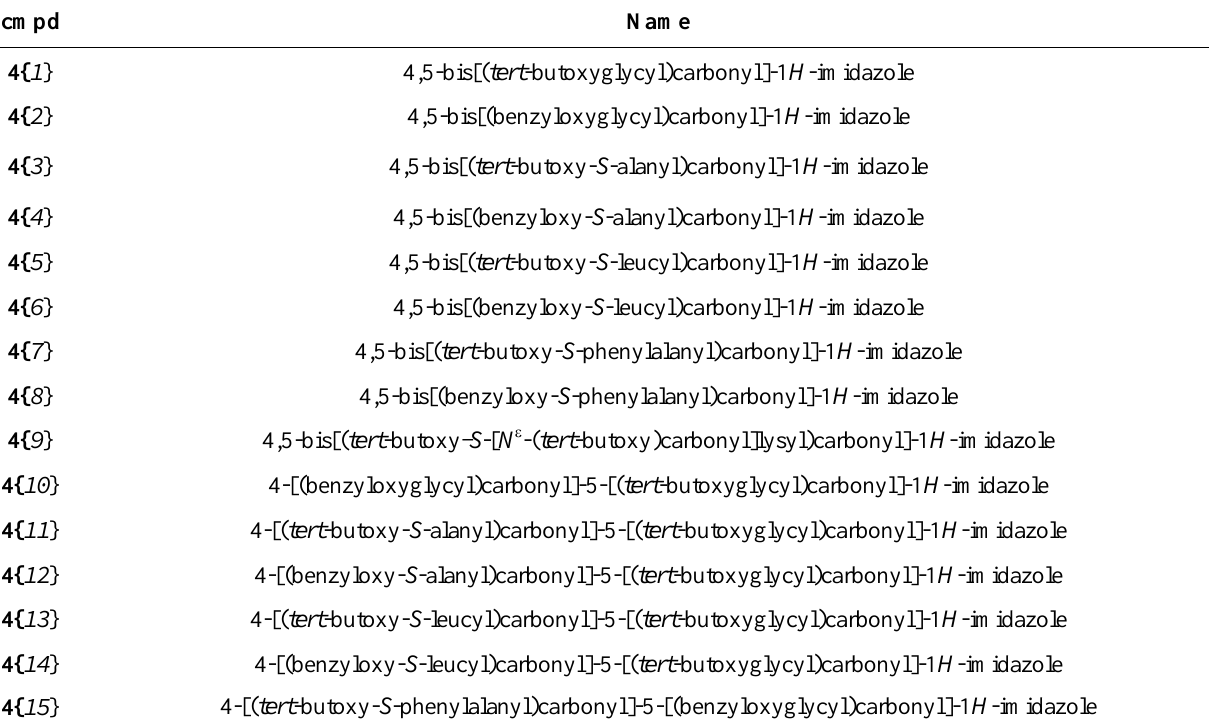
Table 6. Final Product Numbers and